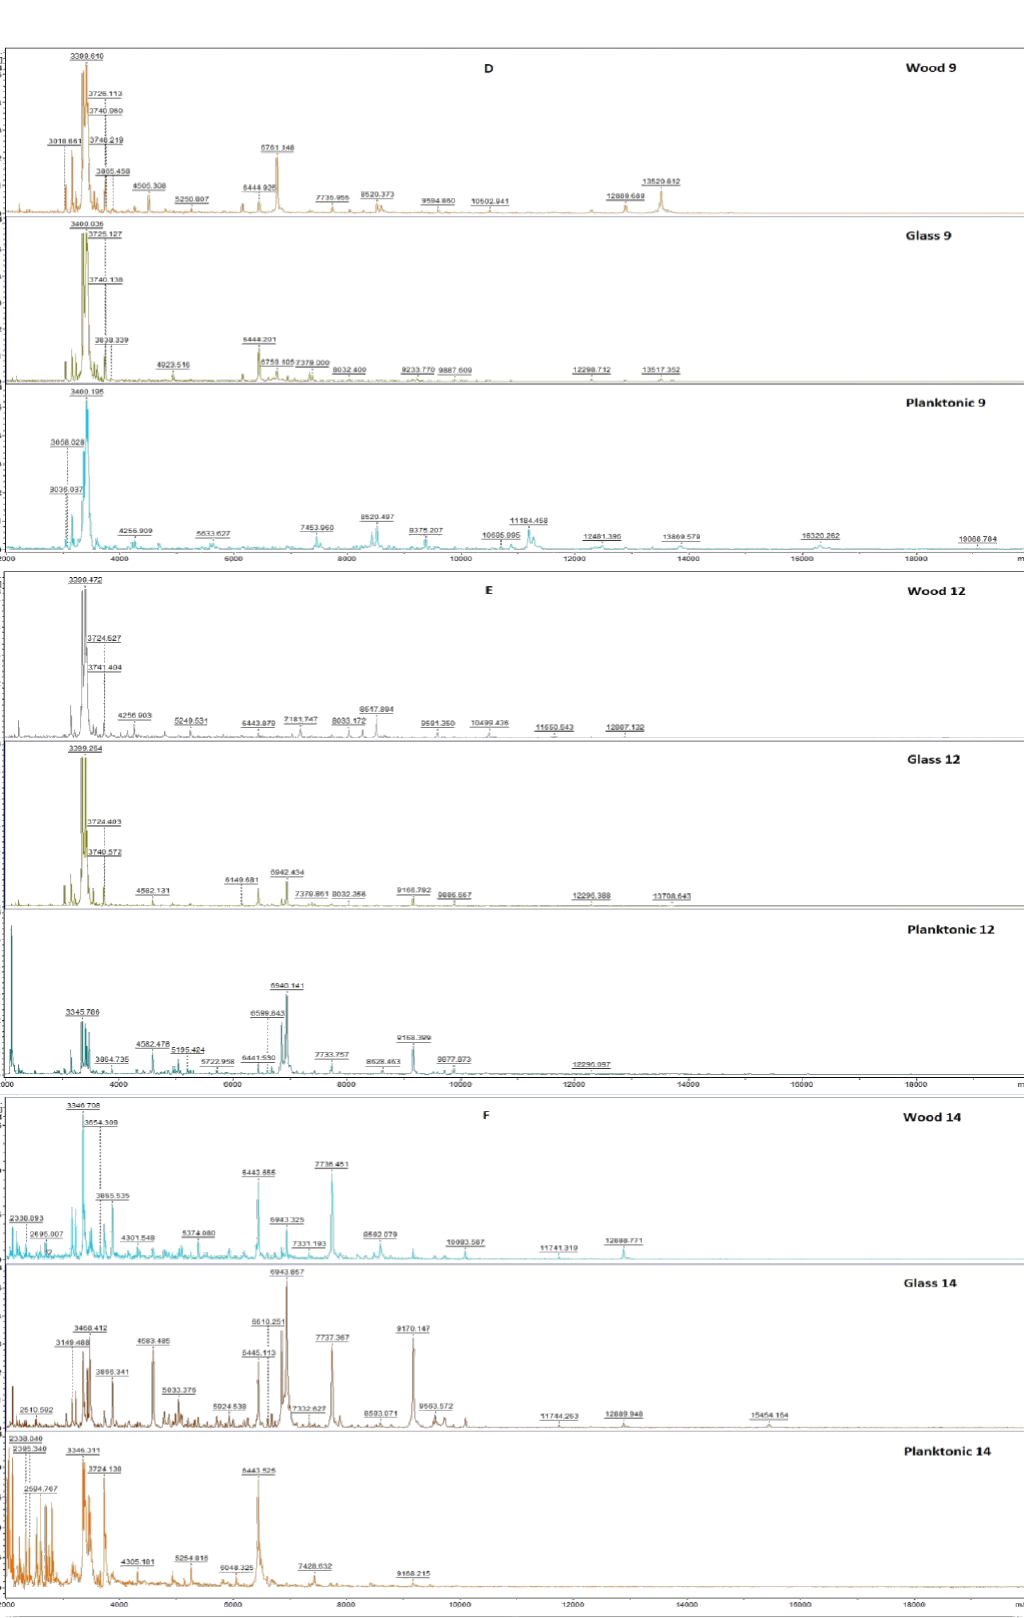
Figure 1. MALDI-TOF mass spectra of S. enteritidis biofilm during development after the addition of T. vulgaris EO: ( A